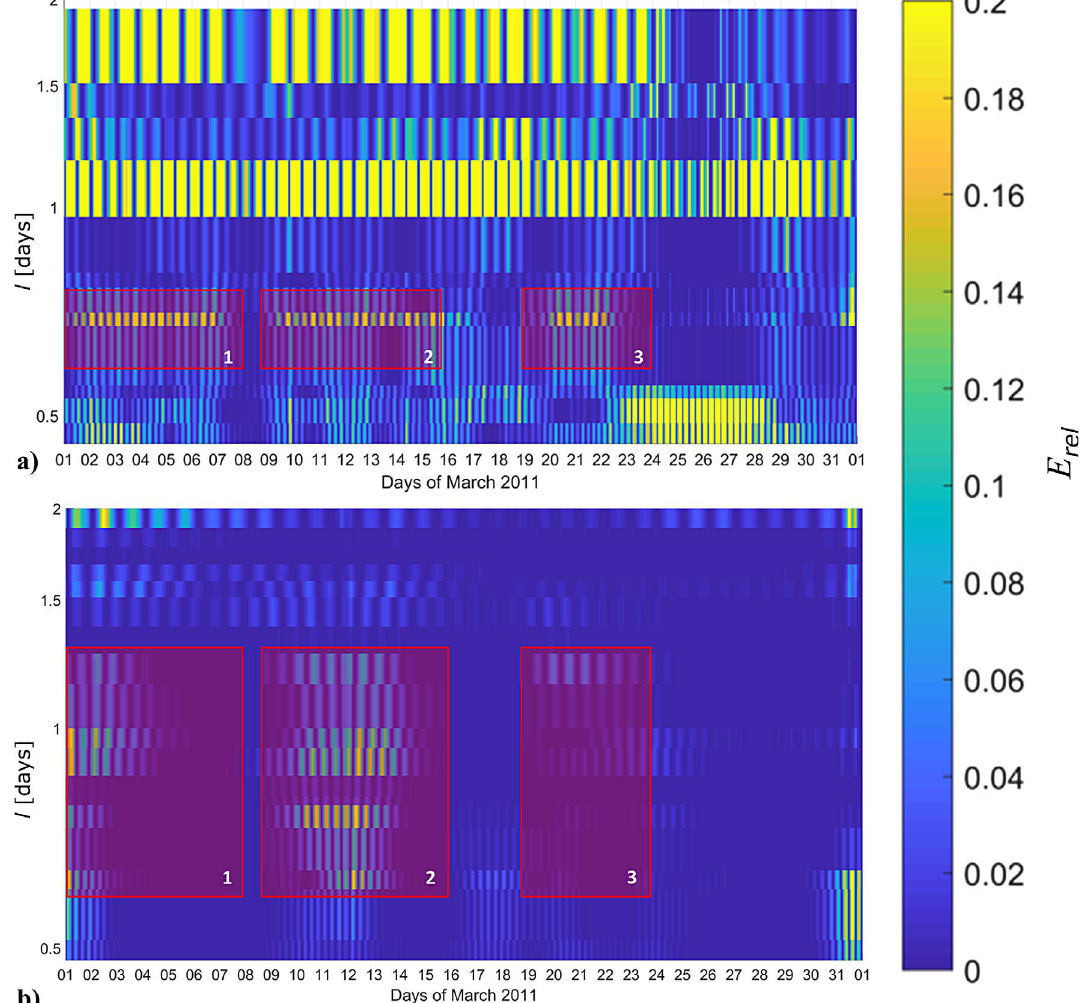
Fig. 7. Instantaneous (1-min) relative energy of each intrinsic mode function of (a) S 4H and (b) e parameter for 1 – 31 March